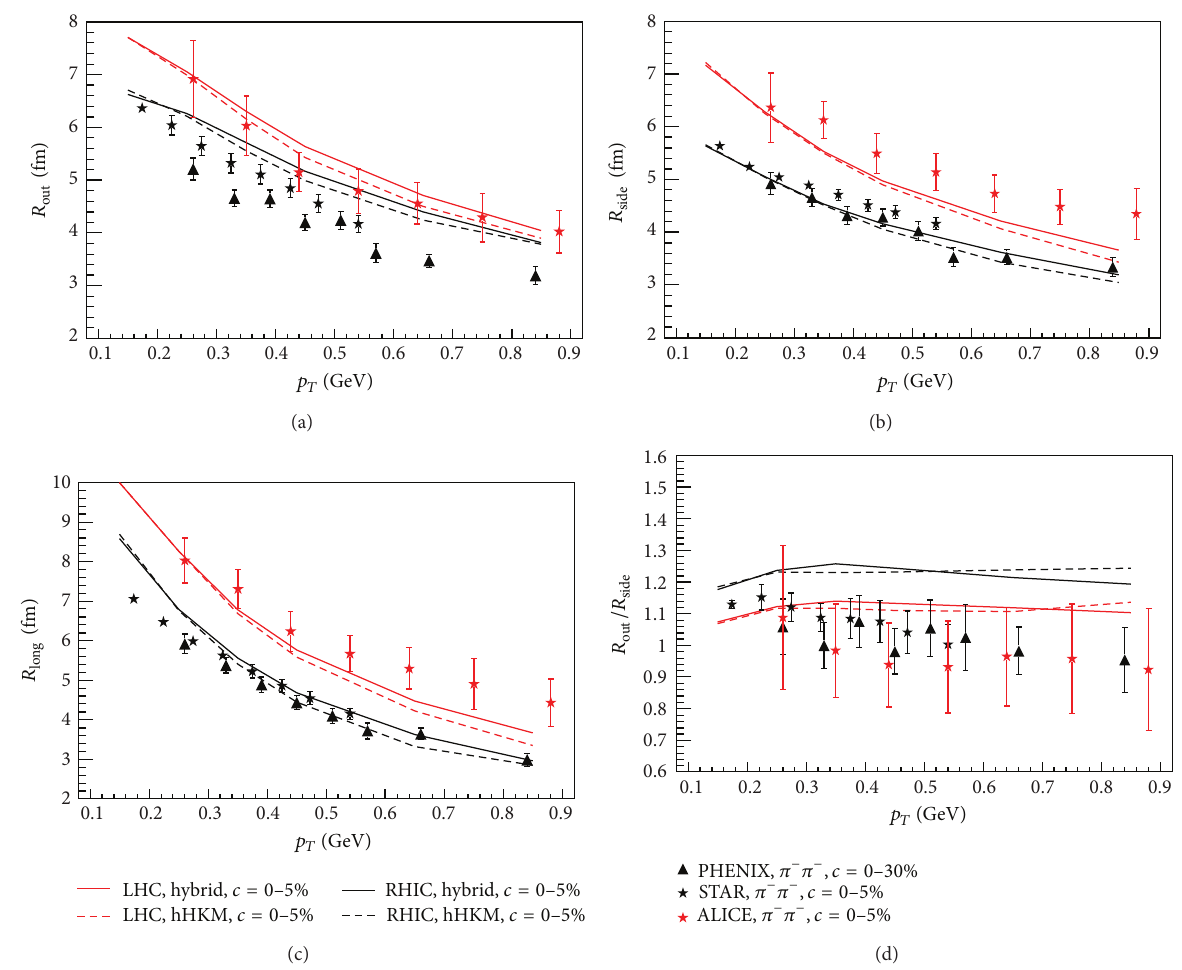
Figure 3: HBT radii of 𝜋 − pairs for the most central events, calculated in the hHKM model and compared to experimental data from ALICE [33]. Dashed lines correspond to hydrokinetic procedure of matching, while solid lines stand for the “hybrid” model case. Corresponding HBT radii for top RHIC energy are shown for comparison